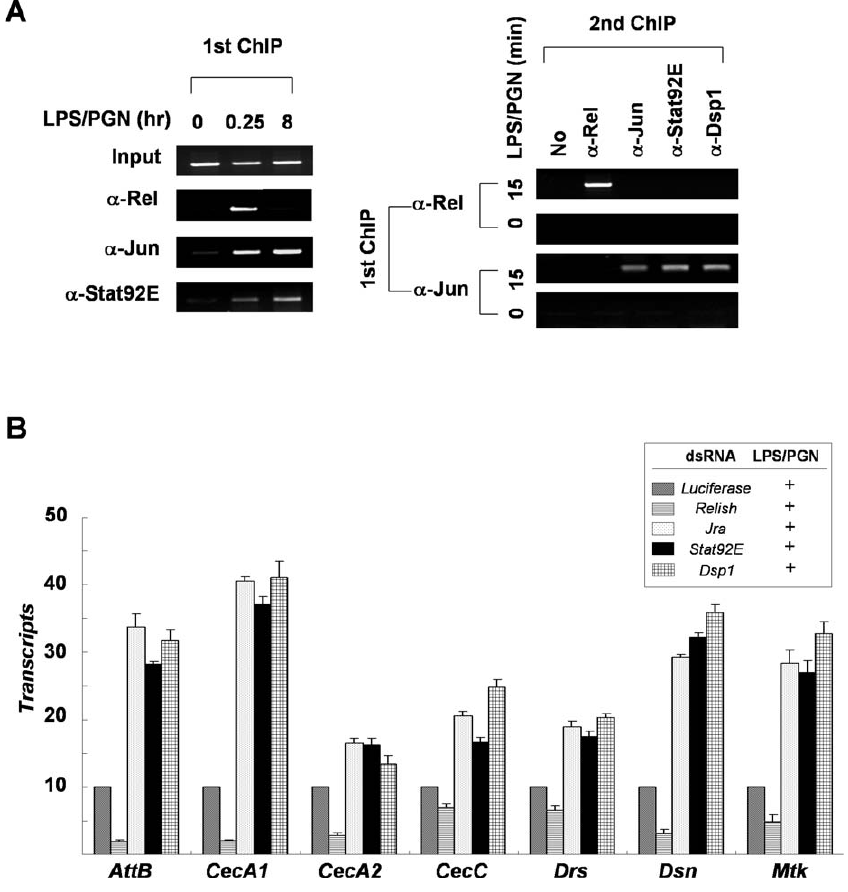
Figure 6. Relish Is Displaced from the Attacin-A Promoter by the Repressosome (A) Left panel: soluble chromatin extracts were prepared from SL2 cells with (15 min or 8 h) or without (0 min) LPS/PGN treatment, and immunoprecipitated with antibodies against Relish, Jun, or Stat92E as described in Figure 3. Right panel: double ChIP assays. The precipitates obtained from the first ChIP of cells with (15 min) or without LPS/PGN treatment were analyzed separately in a second ChIP with the antibodies indicated at the top (second ChIP). The amounts of Attacin-A promoter fragments co-precipitated with the indicated antibody are shown. (B) The transcript levels of each target gene are shown under Luciferase, Relish, Jra, Stat92E, or Dsp1 knock-down conditions with LPS/PGN treatment (10 l g/ml; 1h). The averages and standard deviations of triplicates assays are